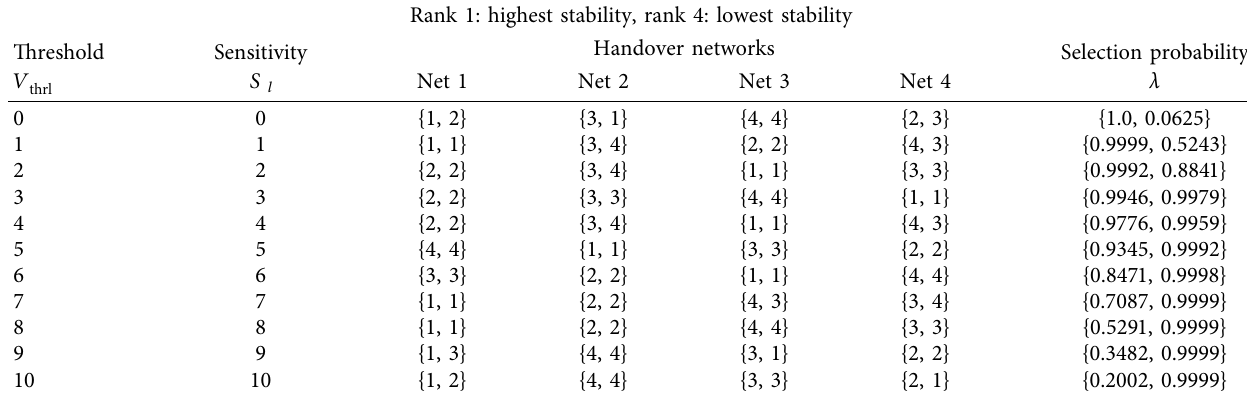
Table 6: Network handover ranking map as a function of both threshold and sensitivity. Rank 1: highest stability, rank 4: lowest stability